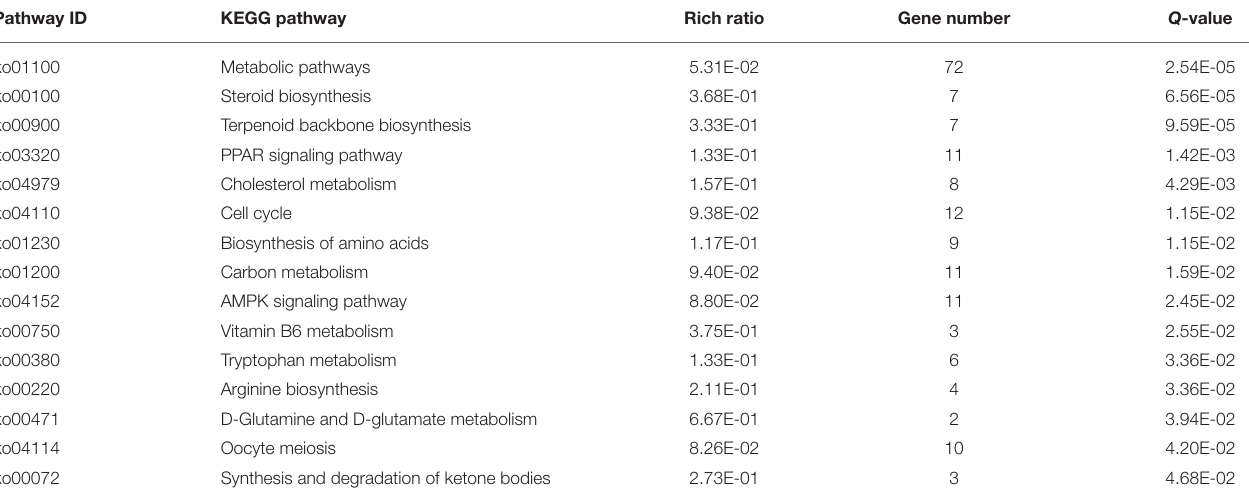
TABLE 5 | Results of the KEGG enrichment analysis of DEGs. Pathway ID KEGG pathway Rich